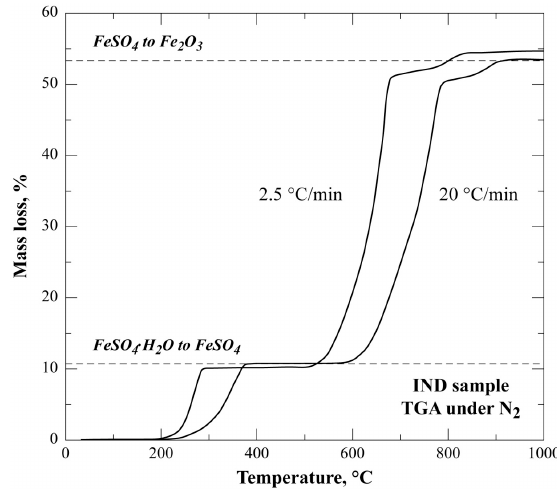
Figure 4. TG analysis in N 2 of the IND sample.